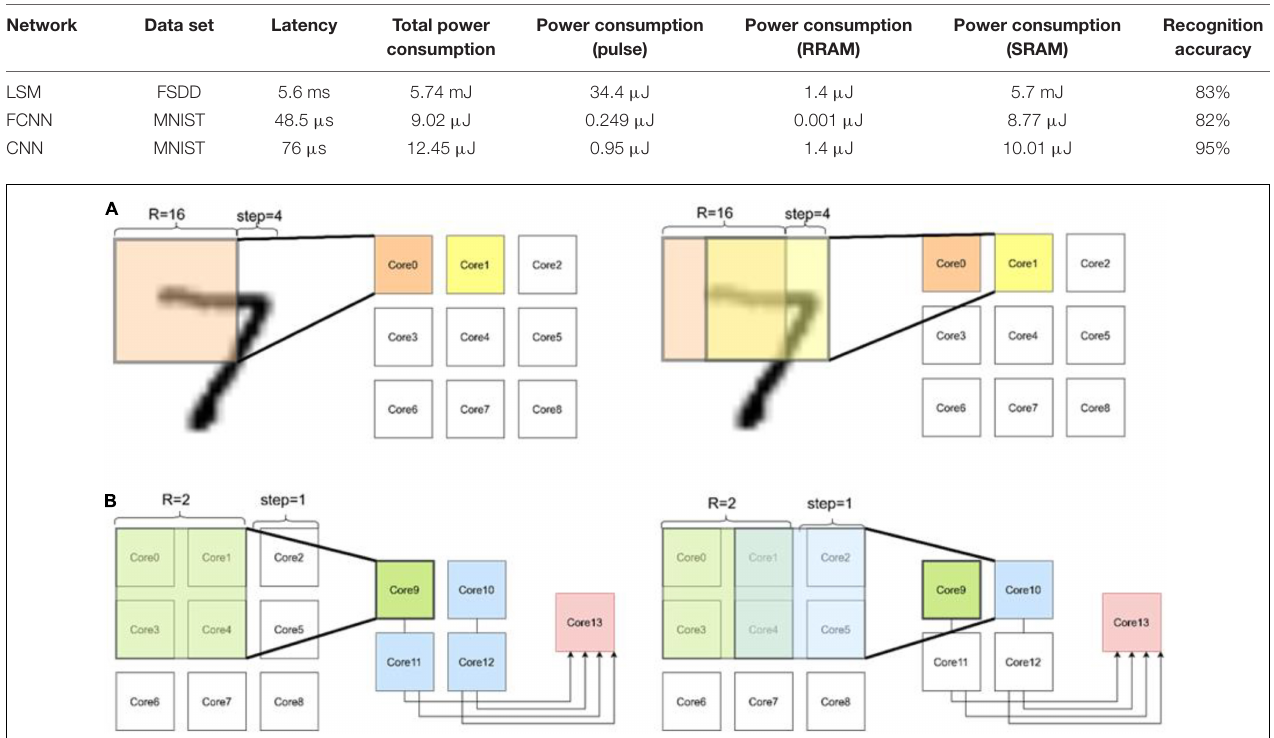
TABLE 2 | Simulation results of FangTianSim.